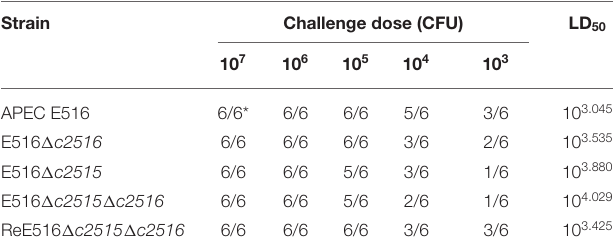
TABLE 3 | LD 50 of wild type strain APEC E516 and its isogenic mutants. Strain Challenge dose (CFU) LD